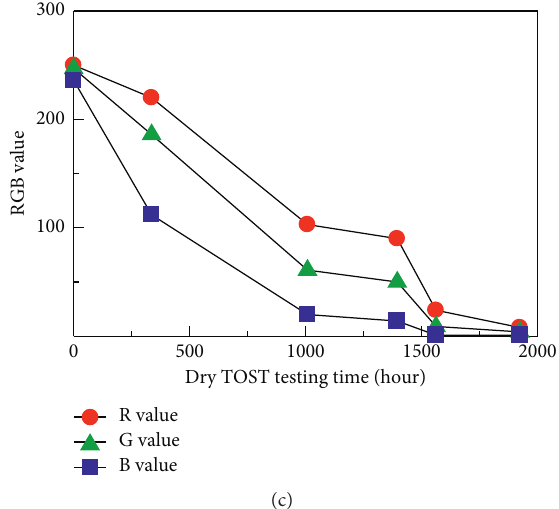
Figure 4: Relationship between dry TOST testing time and RGB values. (a) Sample oil A. (b) Sample oil B. (c) Sample oil C.